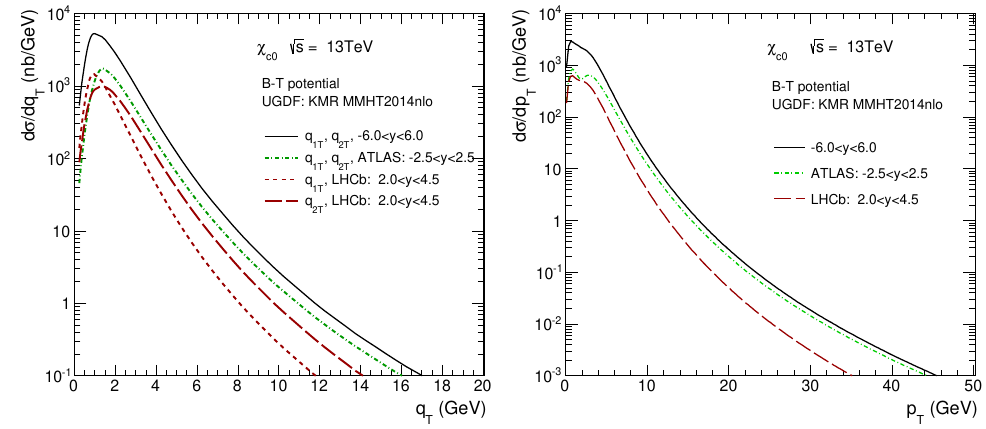
Figure 13 . On the l.h.s. di(cid:11)erential cross section as a function of the transverse momentum of initial gluon ( q 1 T or q 2 T ) with rapidity cuts for the ATLAS and LHCb experiments. On the r.h.s. di(cid:11)erential cross section as a function of the transverse momentum of (cid:31) c with rapidity cuts for the ATLAS and LHCb